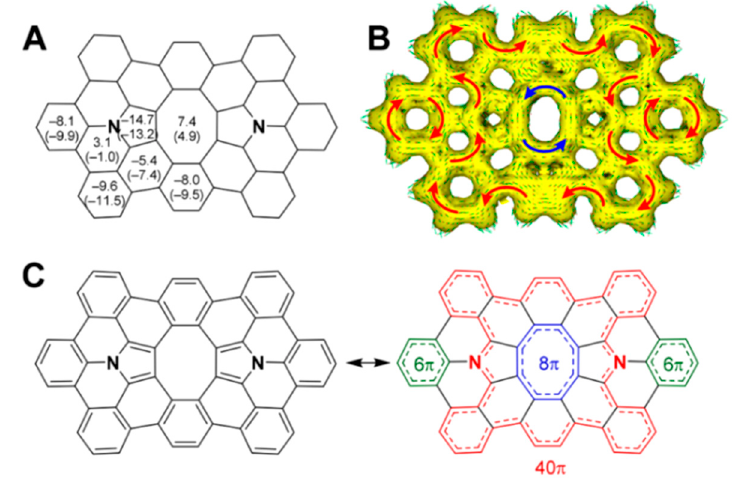
Figure 19. ( A ) NICS(0) values (in ppm) for planar 53 calculated in the gas phase. NICS(1) values are shown in parentheses. ( B ) ACID plot for 53 calculated in the gas phase. ( C ) Bond alternation patterns of 53. Reprinted with permission from Ref. [101]. Copyright 2020 American Chemical Society.